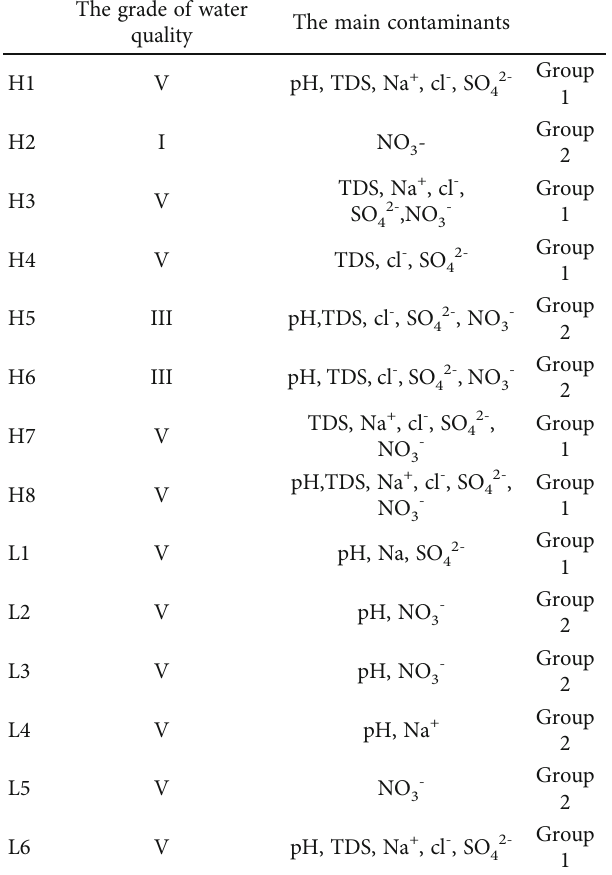
Table 4: The groundwater quality of each site. The grade of water quality